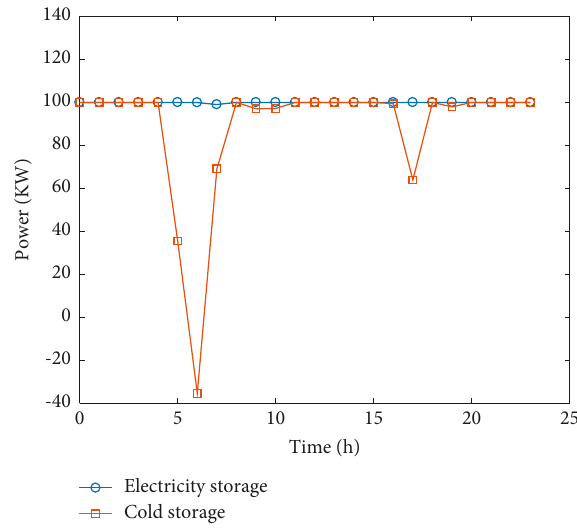
Figure 3: Output of electricity storage and cooling storage